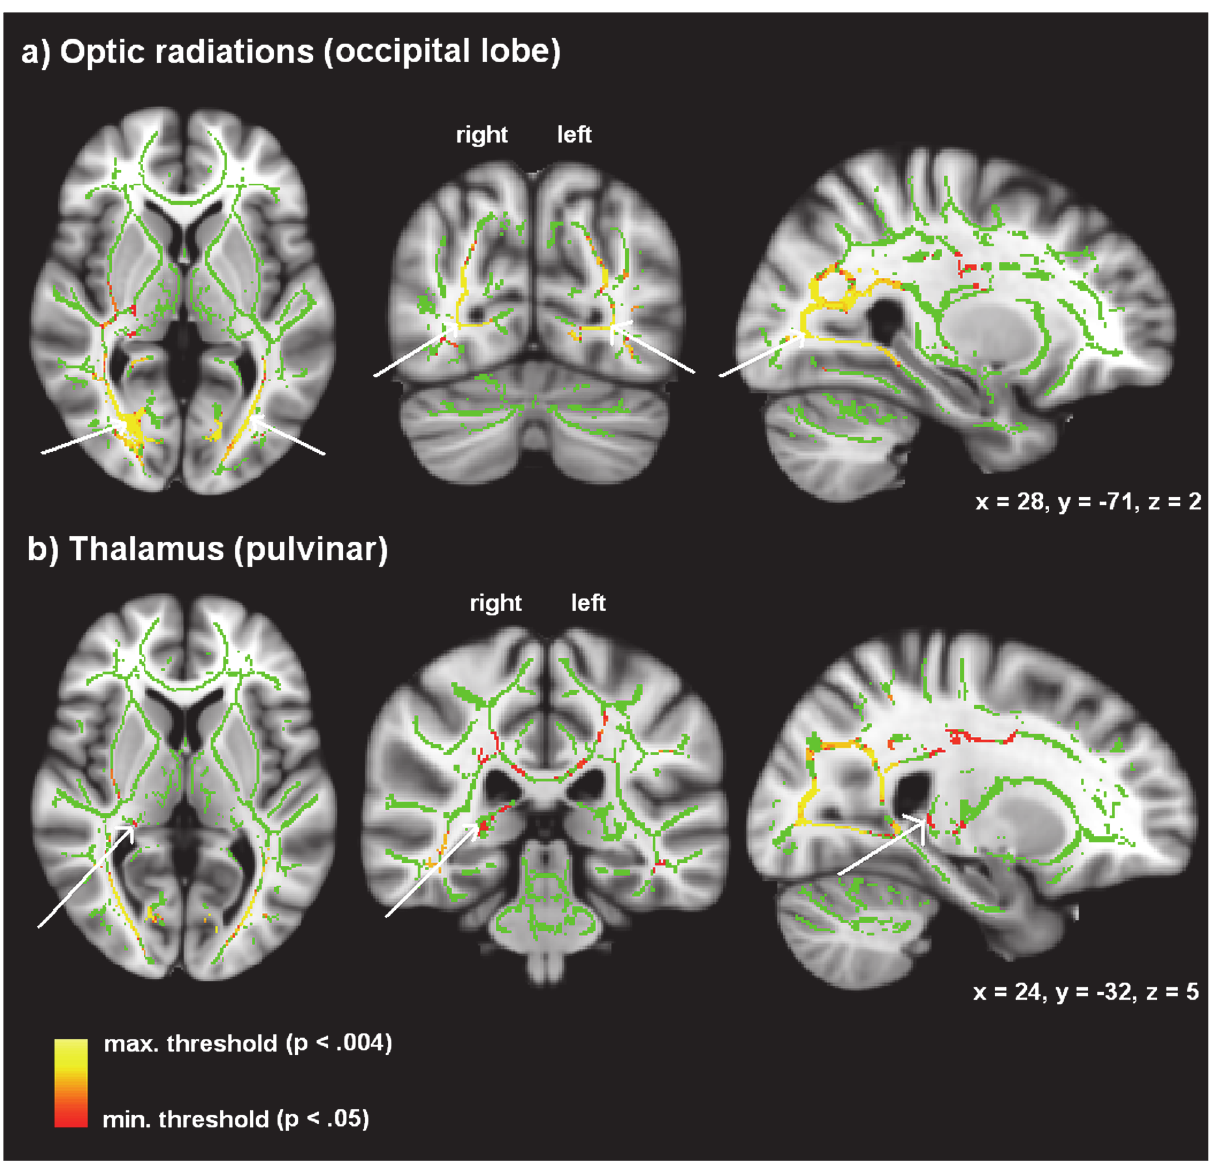
Fig 3. Clusters with reduced FA values in the late-blind compared to the sighted control group (yellow: p < 0.004; red: p < 0.05) overlaid on the mean FA skeleton map (green). Significant effects were found within (a) the optic radiation of both hemispheres and (b) the right-hemisphere dorsal thalamus/Pv (threshold: TFCE statistic, family-wise error (FWE) corrected p < 0.05).